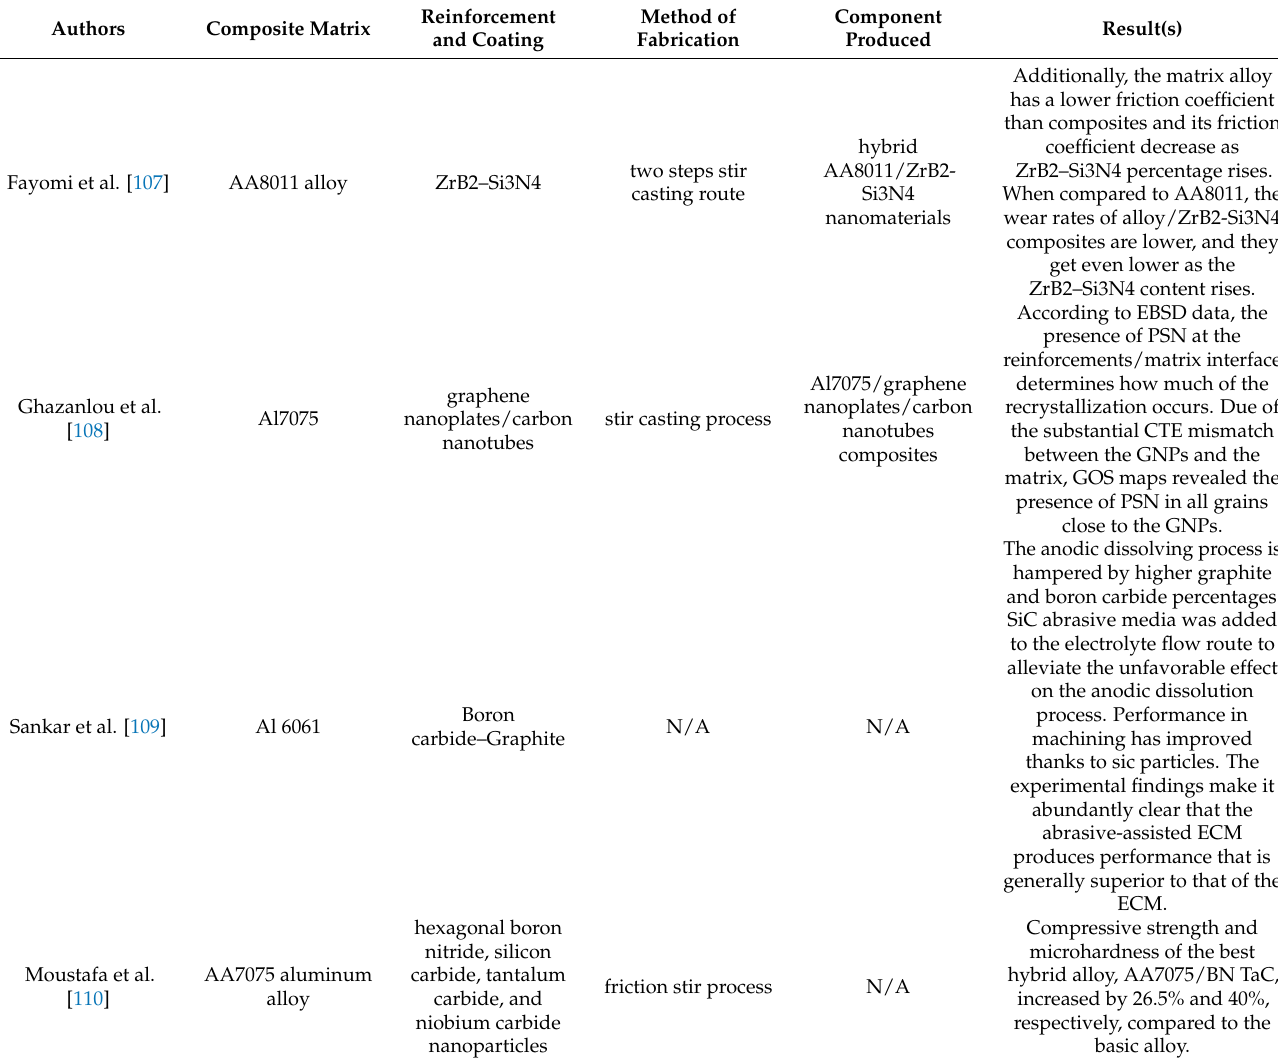
Table 2. Summary of other reinforcement materials for metal matrix